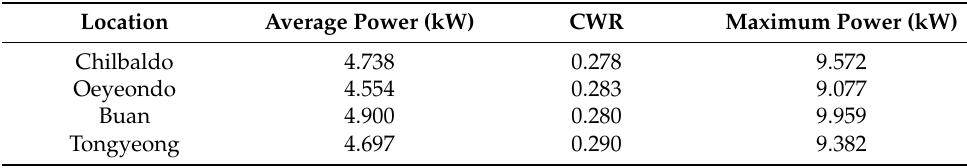
Table 4. Average power, CWR, and peak power at each location.